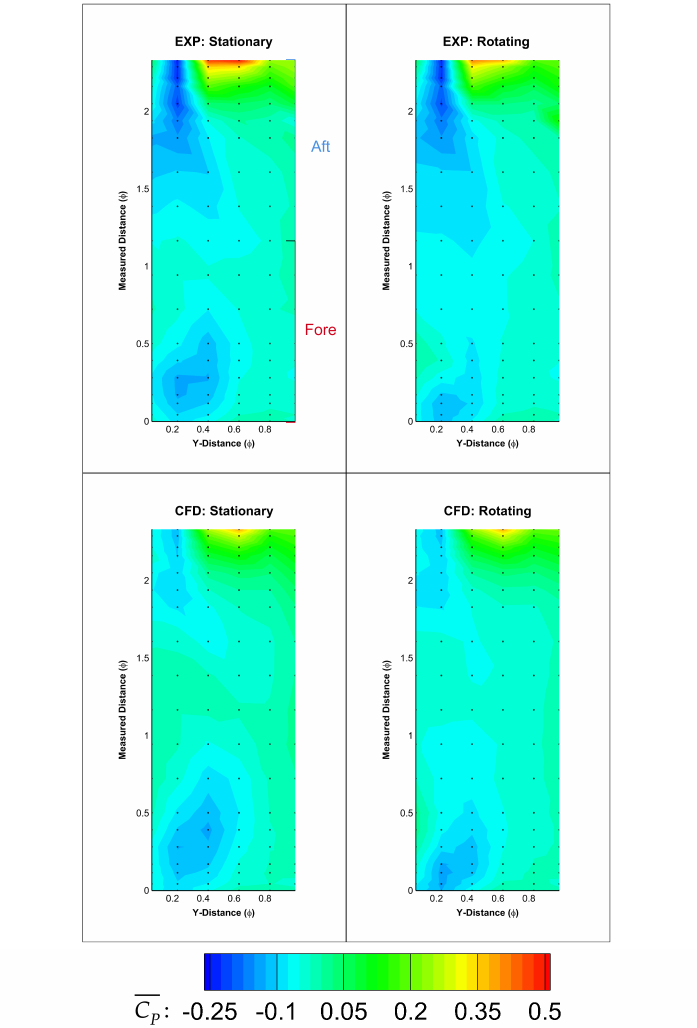
Figure 15. Wheel arch pressures: experimental and